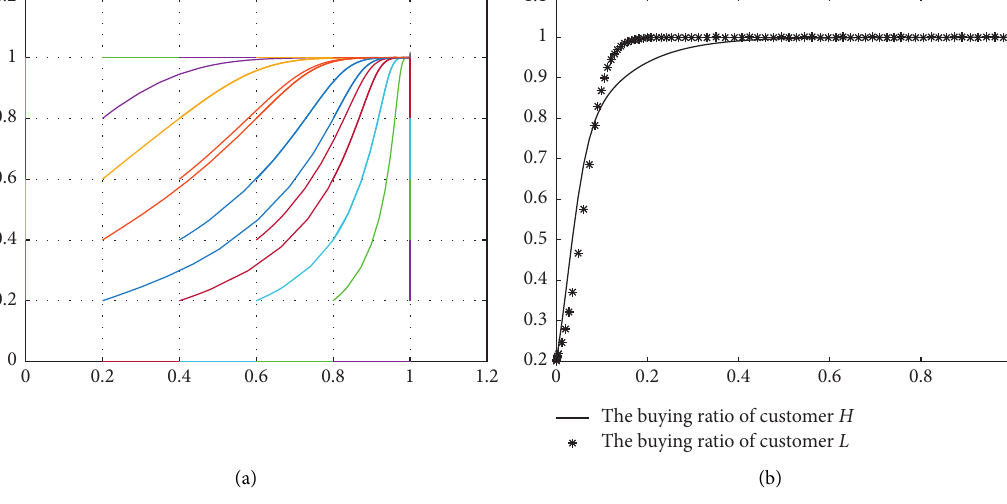
Figure 5: (a) ESS at P < (( 2 − k ) S − r ) /2. (b) System evolution at P < (( 2 − k ) S − r )